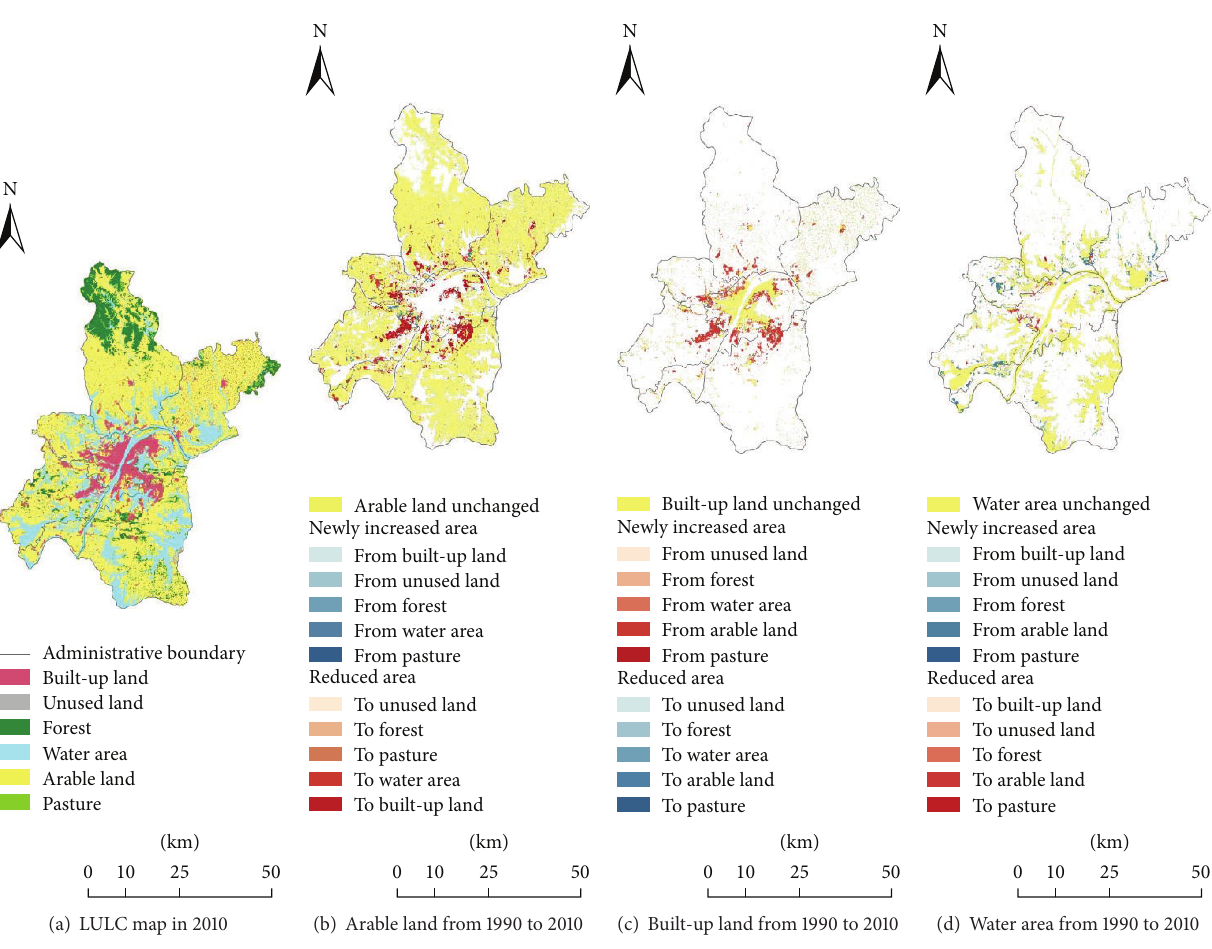
Figure 3: LULC map and the spatial change of main LULC types in Wuhan city from 1990 to